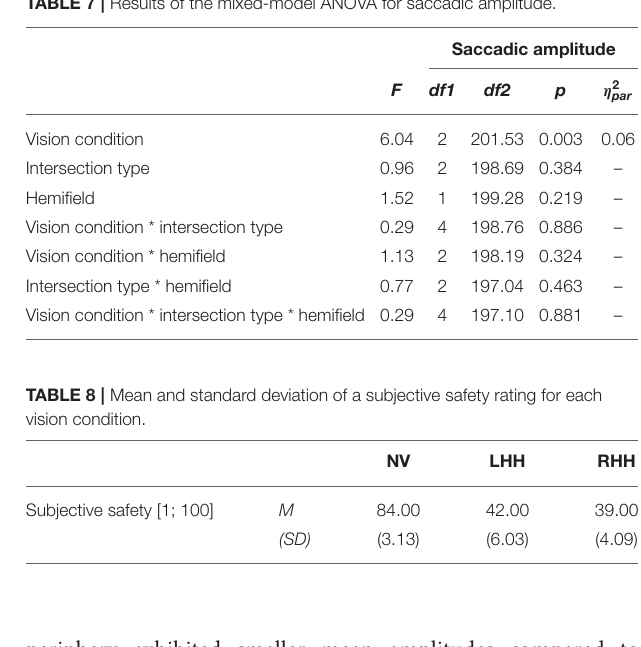
TABLE 7 | Results of the mixed-model ANOVA for saccadic amplitude.